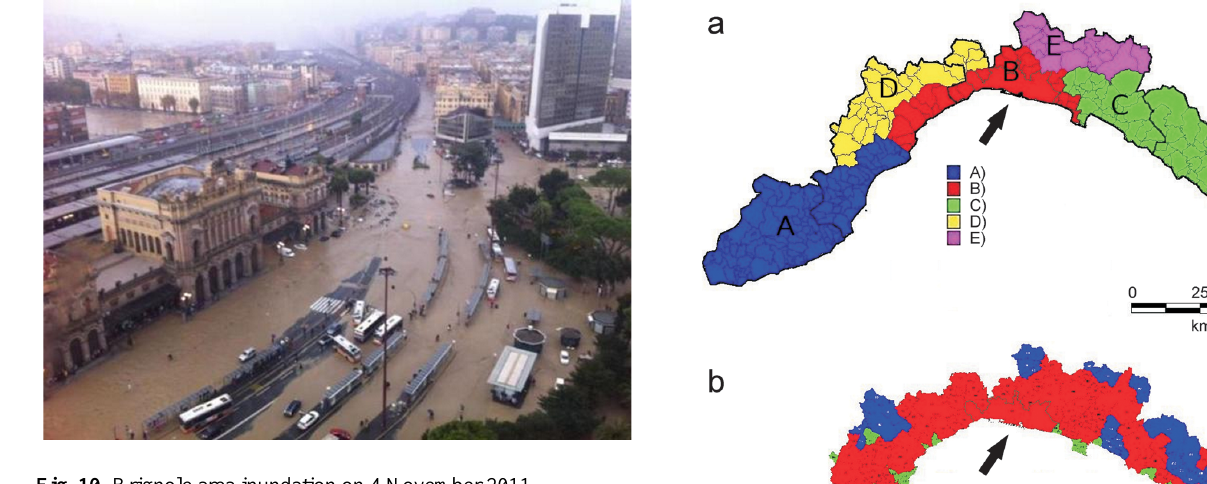
Fig. 10. Brignole area inundation on 4 November 2011.